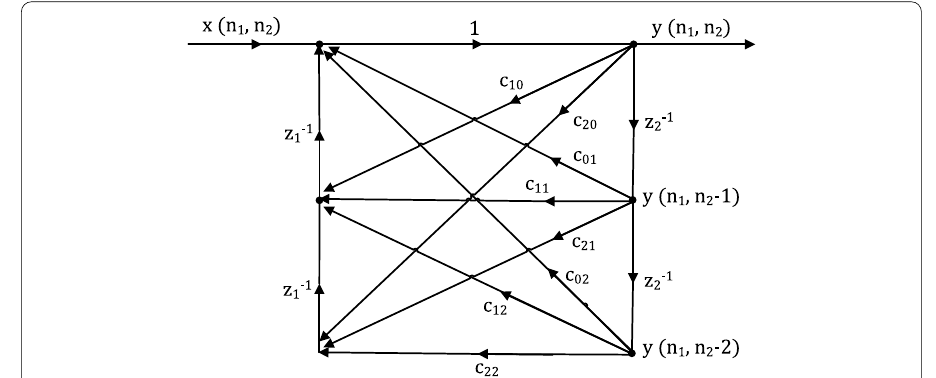
Fig. 2 Flow graph of a second-order image processing